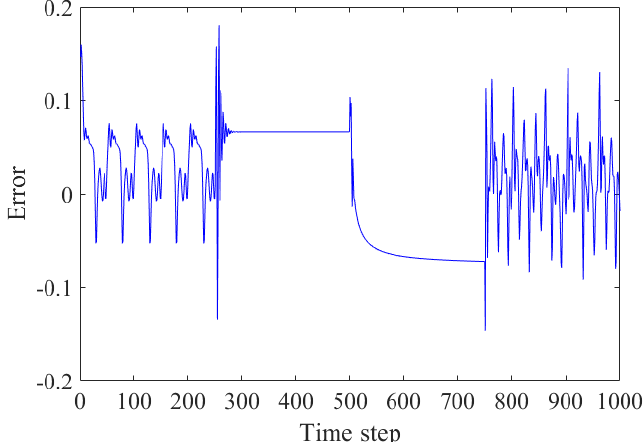
Figure 5. The errors in dynamic system identification between the real output and output obtained using the STFCMAC model.